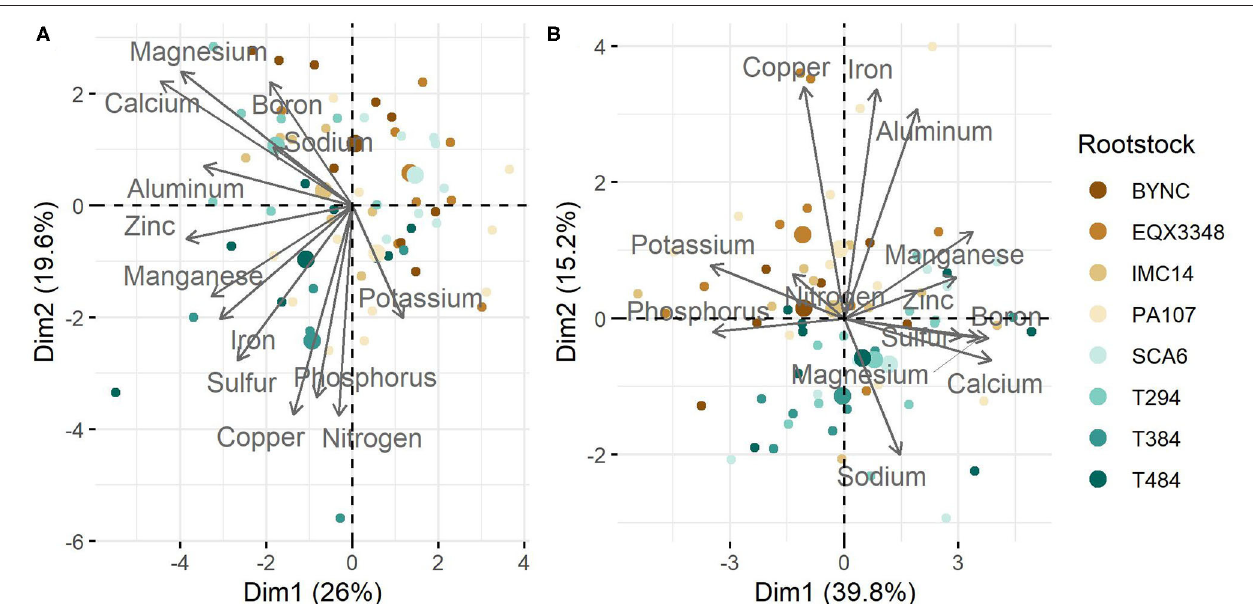
FIGURE 1 | Principal components analysis (PCA) of cacao leaf nutrients at two sampling dates. Values were scaled to have unit variance prior to analysis. (A) At 4 months, 46% of variation in leaf nutrients was accounted for by the first two eigenvectors. Ca, Mg, and Zn had the highest loadings for the first eigenvector (Dim1 above) and N, Cu, and P had the highest loadings for the second eigenvector (Dim2). (B) At 16 months, 55% of variation was accounted for by the first two eigenvectors, which were driven by K, P, Ca, and B (Dim1) and Fe, Cu, and Al